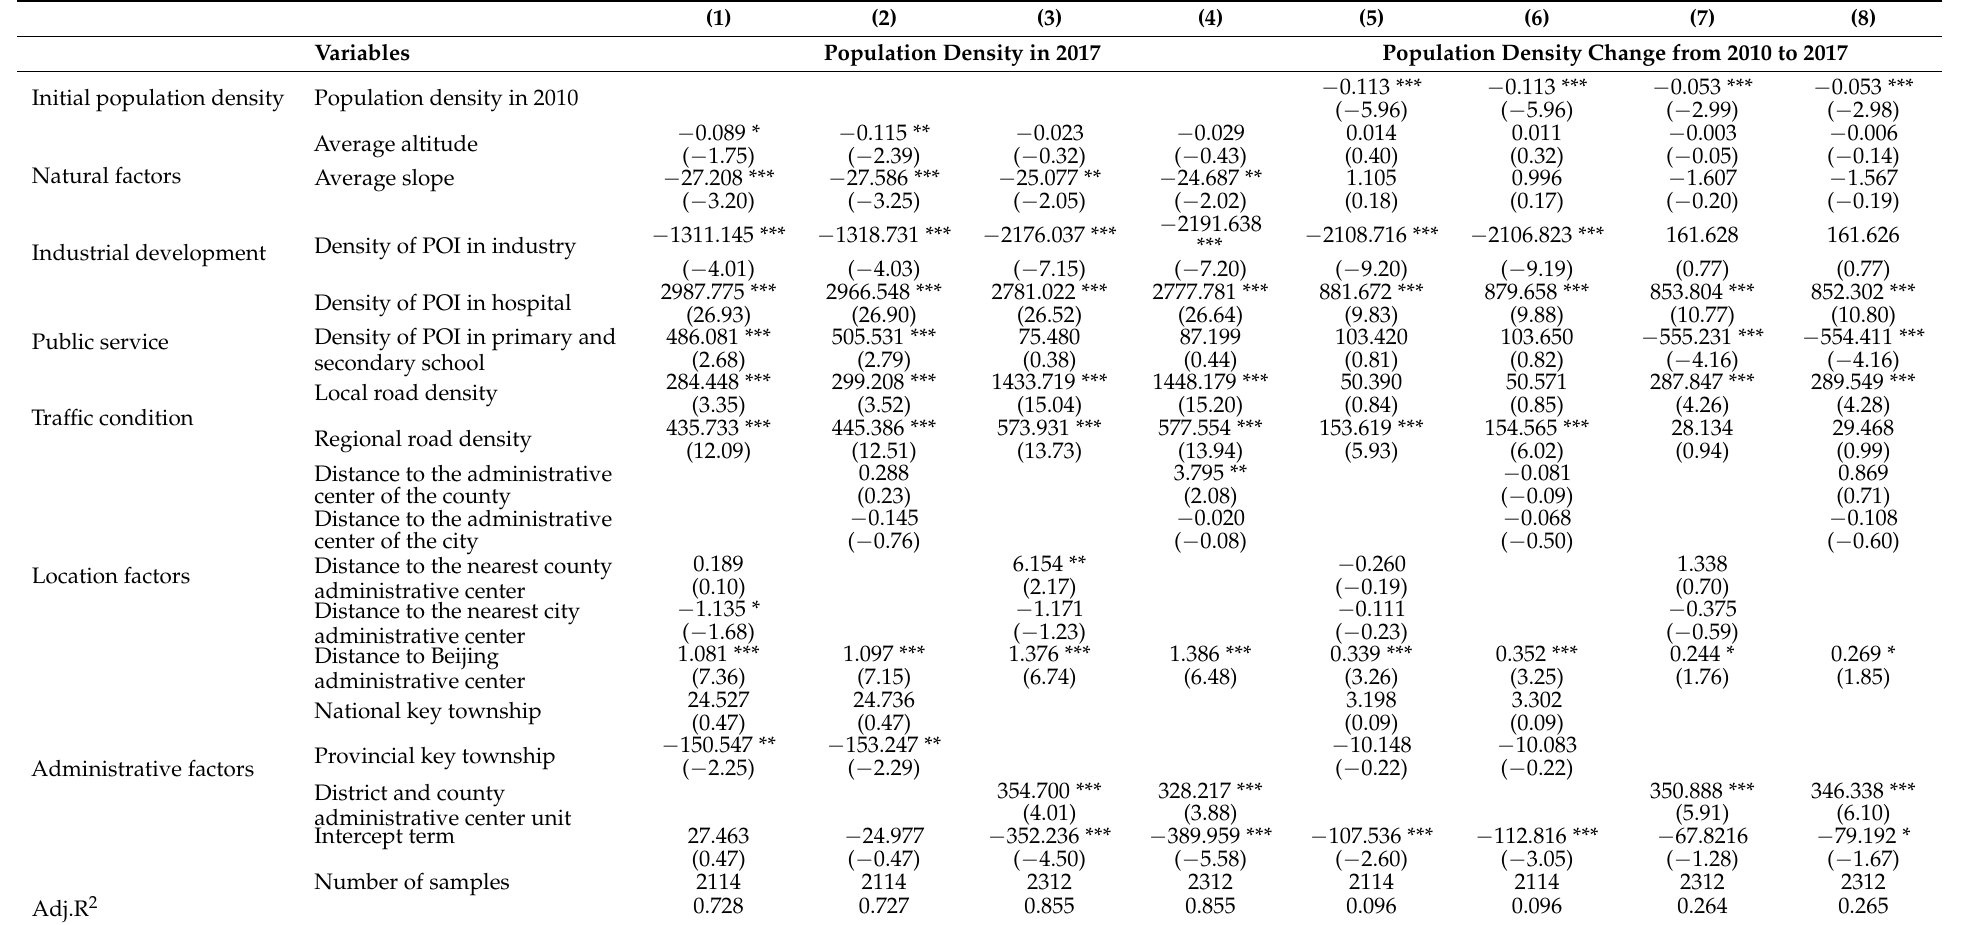
Table 3. Population distribution and change regression results from 2010 to